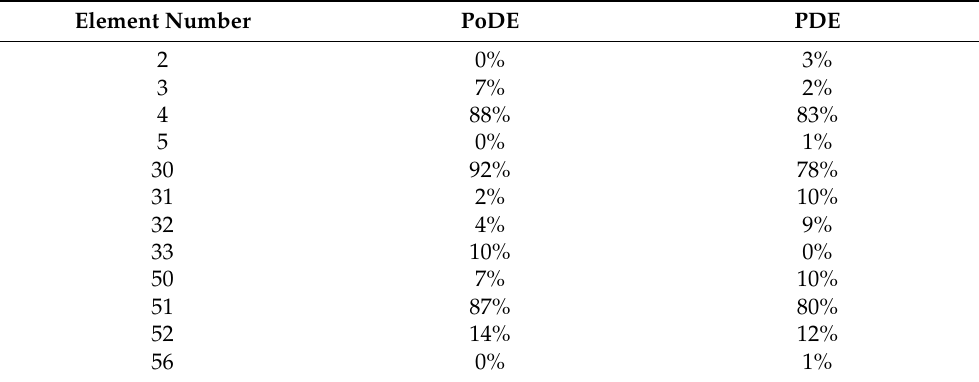
Table 10. PoDE for damage case 2 of the dome truss with ξ λ =